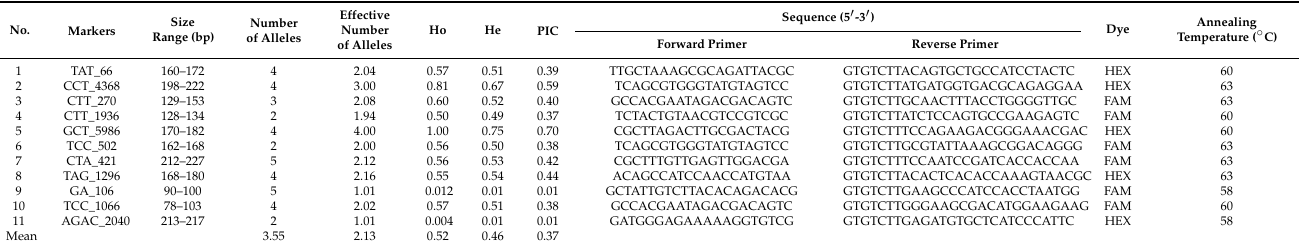
Table 1. Sequences of SSR Primers and Characteristics of